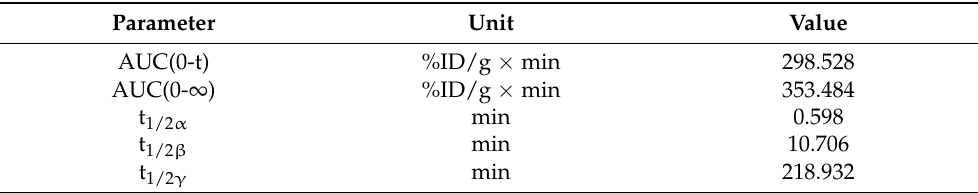
Table 1. Major pharmacokinetics parameters derived by three-compartmental modeling after